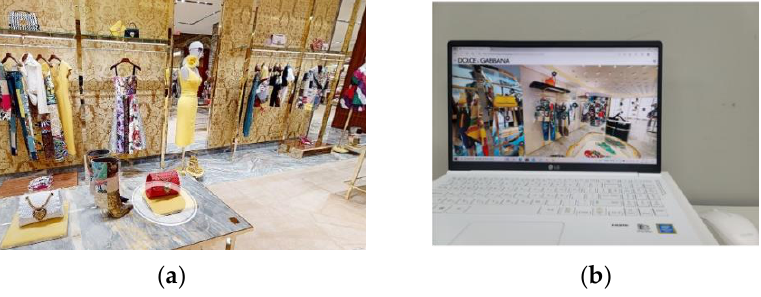
Figure 2. ( a ) Immersive VR type; ( b ) Non-Immersive VR